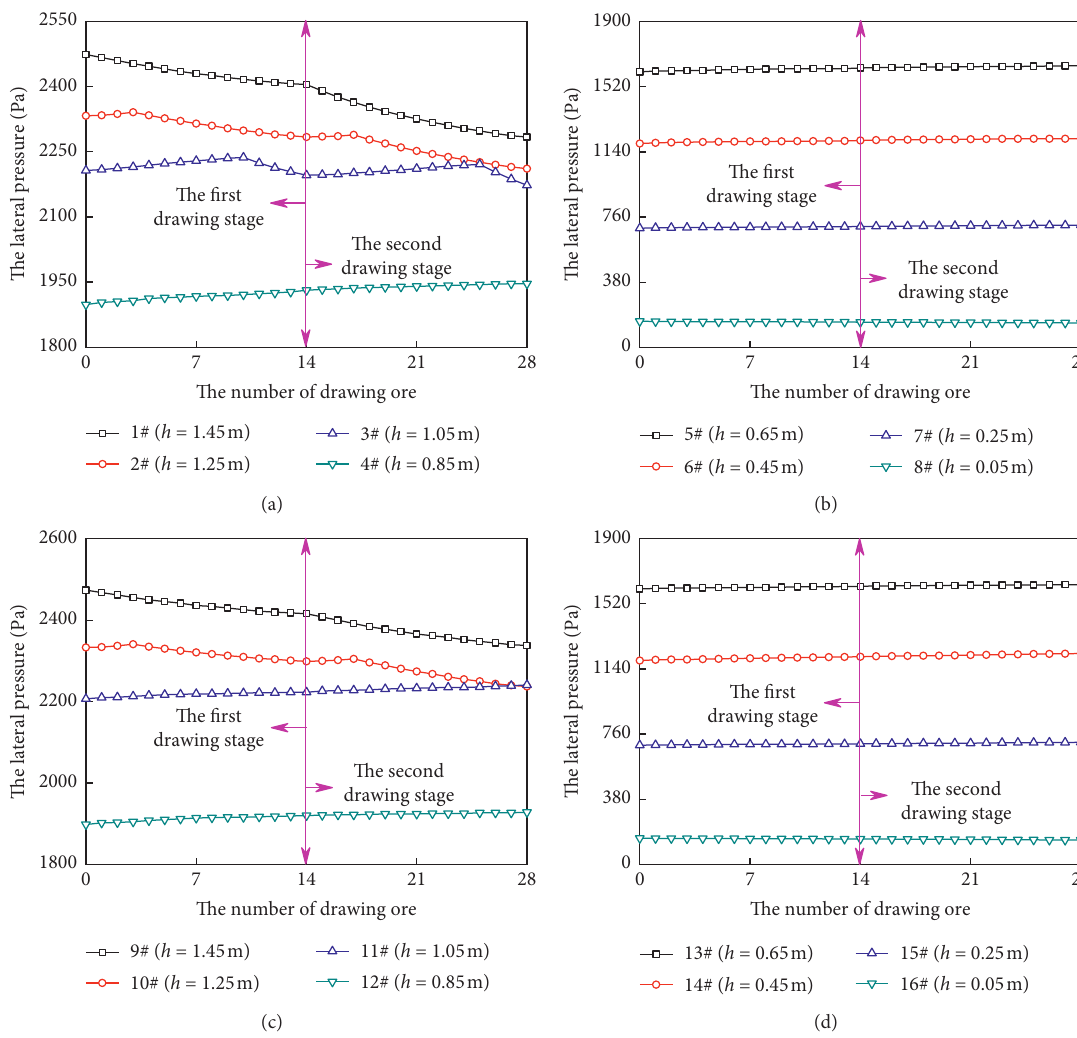
Figure 11: The relationship between the number of drawing ore and the values of lateral pressure with scheme